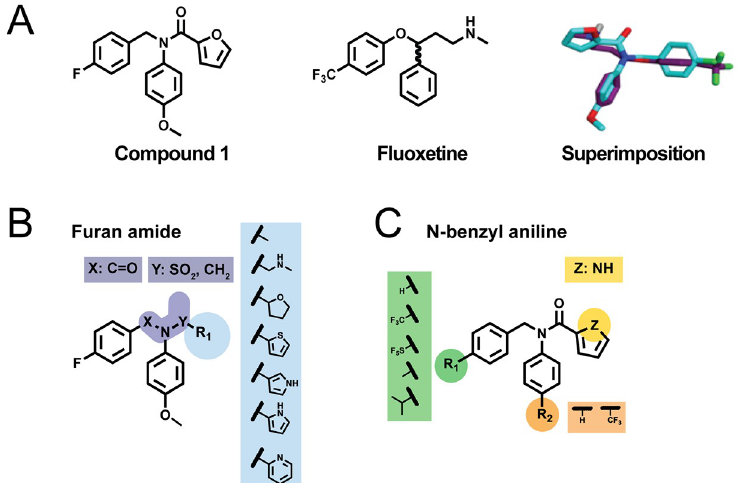
Fig 1. Structural comparison of fluoxetine and compound 1. (A) The compounds fluoxetine and compound 1, and a superimposition of them, are depicted. (B) The furan moiety (R1) is highlighted in blue and the amide moiety (X-N-Y) in purple. The substitutions that were explored are shown in the purple and blue boxes. (C) The R1 (green) and R2 (orange) moieties of the N-benzylaniline were substituted to the modifications shown in green and orange boxes. Additionally, the heteroatom (yellow) in the furan moiety was